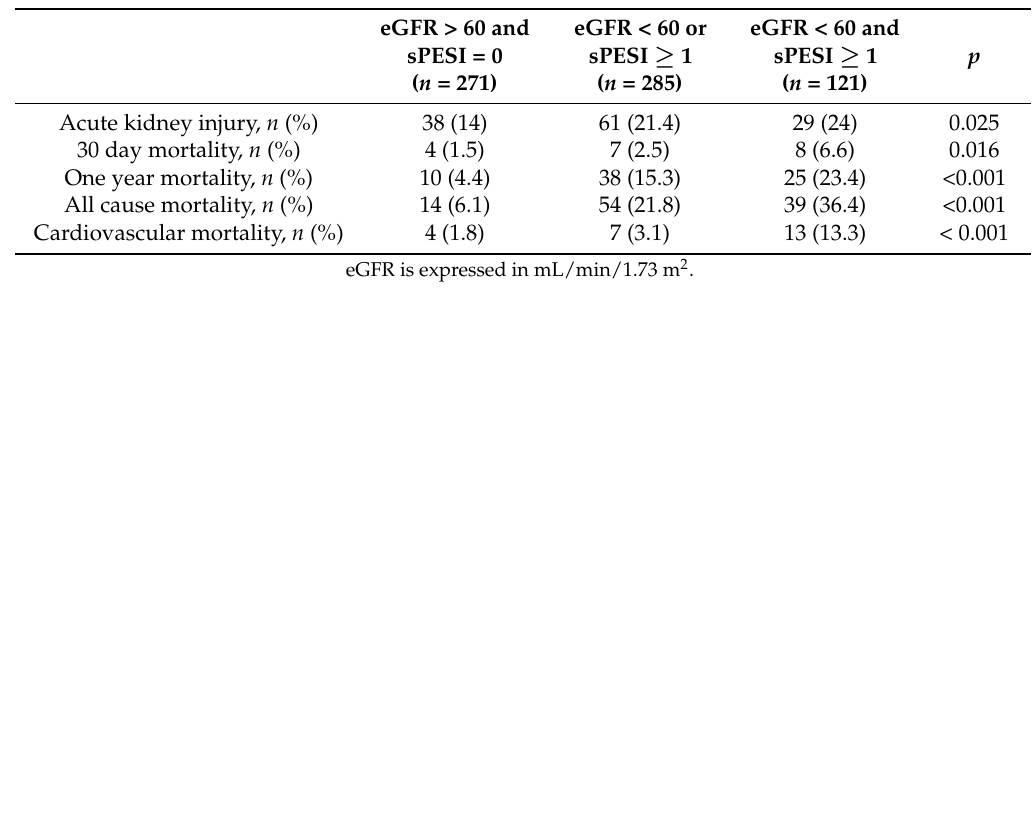
Table 7. Events according to renal dysfunction on admission and sPESI